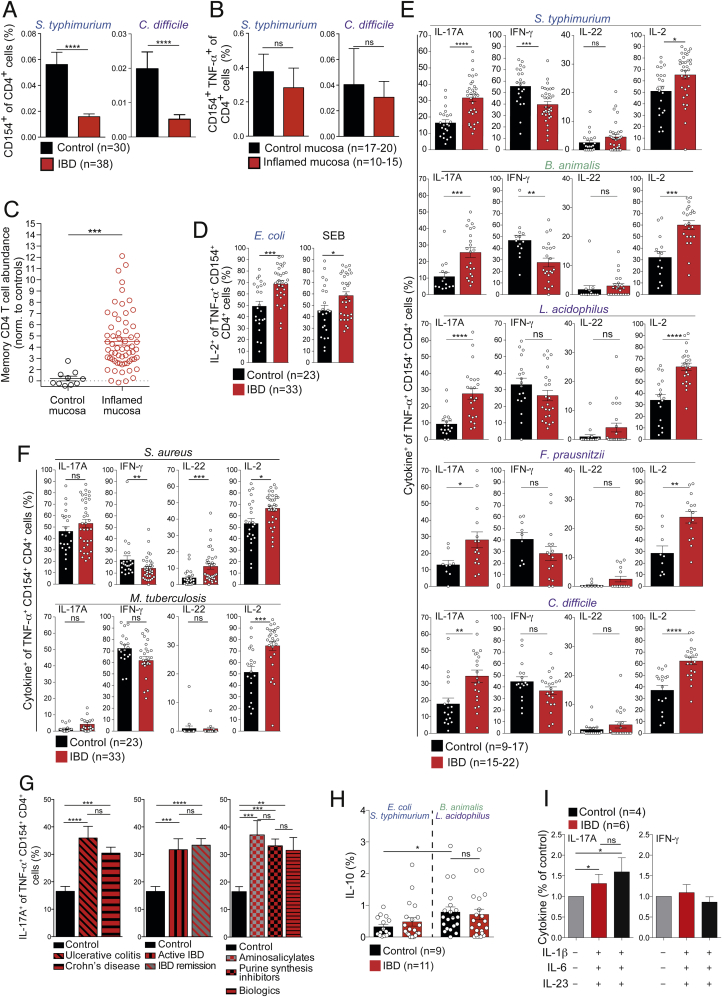
Functional characteristics of enteric bacteria-reactive CD4+ T cells in IBD (related to Figure 7). (A) PBMCs isolated from healthy donors or IBD patients were stimulated with the indicated heat-inactivated bacteria and analyzed for CD154 expression. Frequencies (±SEM) of reactive CD154+ cells among CD4+ T cells in peripheral blood are depicted (n = 30−38). Demographic and clinical characteristics of IBD patients are summarized in Supplementary Table 6. (B) Lamina propria mononuclear cell (LPMCs) were isolated from inflamed surgical specimens from IBD patients or non-inflamed and tumor-free surgical specimens from colorectal cancer patients. Isolated LPMCs were stimulated with the indicated heat-inactivated bacteria and analyzed for CD154 expression. Frequencies (±SEM) of reactive CD154+ TNF-α+ cells among CD4+ T cells in peripheral blood are depicted (n = 10−20). (C) Microarray analysis of intestinal biopsies obtained at endoscopy (n = 6 controls, 24 ulcerative colitis (UC) and 37 Crohn’s disease (CD); Gene Expression Omnibus entry GSE16879). The relative abundance of memory CD4+ T cells in control and inflamed IBD tissue was estimated in silico using CIBERSORT (see Supplementary Methods for details). (D−F) PBMCs isolated from healthy and IBD patients were stimulated with the indicated heat-inactivated bacteria or SEB and analyzed for CD154 expression and intracellular cytokine expression. Demographic and clinical characteristics of IBD patients are summarized in Supplementary Table 6. (D) IL2 expression in CD154+ TNF-α+ memory CD4+ T cells after stimulation with the indicated heat-inactivated bacteria or SEB. Frequencies (±SEM) of 23-33 independent donors. Each dot represent an independent donor. (E, F) IL17A, IFN-gamma, IL22, and IL2 expression in CD154+ TNF-α+ memory CD4+ T cells after stimulation with the indicated heat-inactivated bacteria. Each dot represents an independent donor. Demographic and clinical characteristics of IBD patients are summarized in Supplementary Table 6. (G) IL17A expression in CD154+ TNF-α+ memory CD4+ T cells after stimulation with S typhimurium. IBD patients were categorized by disease phenotype (UC, CD), disease activity according to clinical notes, and current treatment. (H) Total memory CD4+ T cells were isolated from healthy controls or IBD patients blood, labeled with CFSE and cultured with autologous irradiated monocytes in the presence of the indicated heat-inactivated bacteria or antigens. Production of IL10 by expanded CFSElow CD4+ cells after phorbol myristate acetate (PMA)/ionomycin stimulation on day 7 of stimulation. Frequencies (±SEM) are depicted from 9−11 independent donors. (I) CD4+CD45RO+CD45RA−CD25−CD8− memory CD4+ T cells were isolated from healthy controls or IBD patients blood, labeled with CFSE, and stimulated with autologous monocytes pulsed with B animalis in the presence or absence of the indicated cytokines. Data represent mean (±SEM) fold changes in IL17A or IFN-gamma expression frequencies relative to cells expanded without cytokines. Statistics: (A−E, G−H) Mann-Whitney test; (F) 1-way analysis of variance with Sidak’s multiple comparison test; ns, not significant; ∗P ≤ .05; ∗∗P ≤ 0.01; ∗∗∗P ≤ .001; ∗∗∗∗P ≤ .0001.